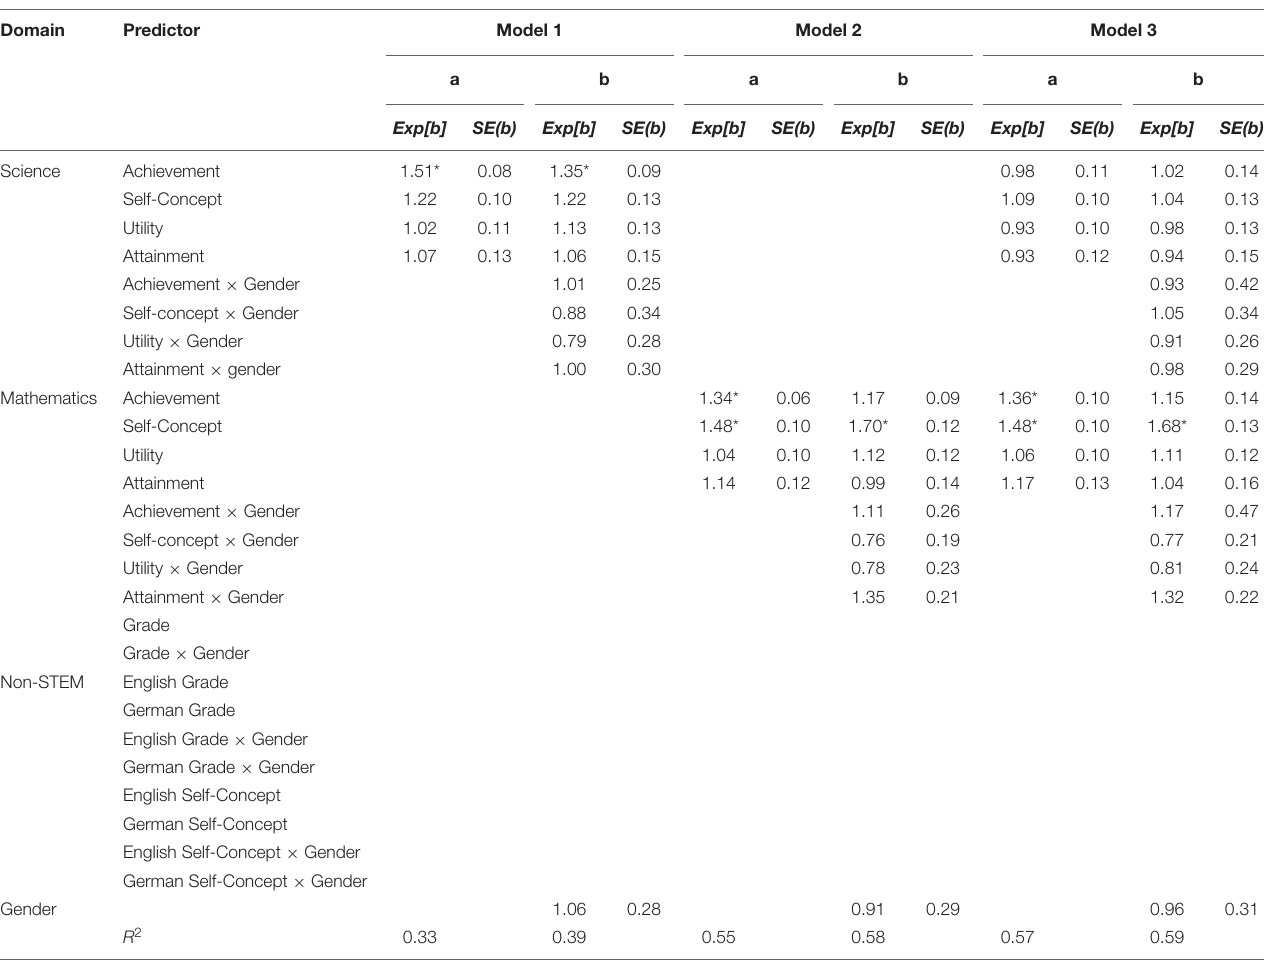
TABLE 2 | Logistic regression for the prediction of science-oriented vs. science-avoidance final exam choice patterns by prior performance, expectancy value variables in mathematics, science, English, and German (odds ratios).